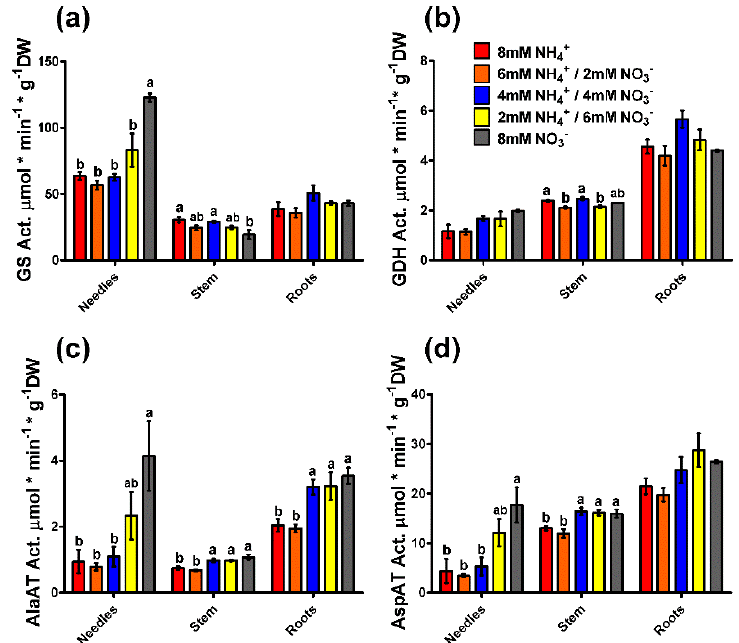
Figure 4. Enzyme activity in the di ff erent organs (needles, stem, and roots) of pine seedlings under the nutrient treatments. ( a ) Glutamine synthetase (GS, EC 6.3.1.2) activity; ( b ) Glutamate dehydrogenase (GDH, EC 1.4.1.3) activity; ( c ) Alanine aminotransferase (AlaAT, EC 2.6.1.2) activity; ( d ) Aspartate aminotransferase (AspAT, EC 2.6.1.1) activity. Red columns correspond to 8 mM NH 4 + supply; orange columns correspond to 6 mM NH 4 + / 2 mM NO 3 − supply; blue columns correspond to 4 mM NH 4 + / 4 mM NO 3 − supply; yellow columns correspond to 2 mM NH 4 + / 6 mM NO 3 − supply; grey columns correspond to 8 mM NO 3 − supply. Significant di ff erences were determined with a one-way ANOVA for each organ or entire seedling. Letters above the columns show significant di ff erences based on a Newman-Keuls post-hoc test ( p < 0.05). Error bars show SE with n =